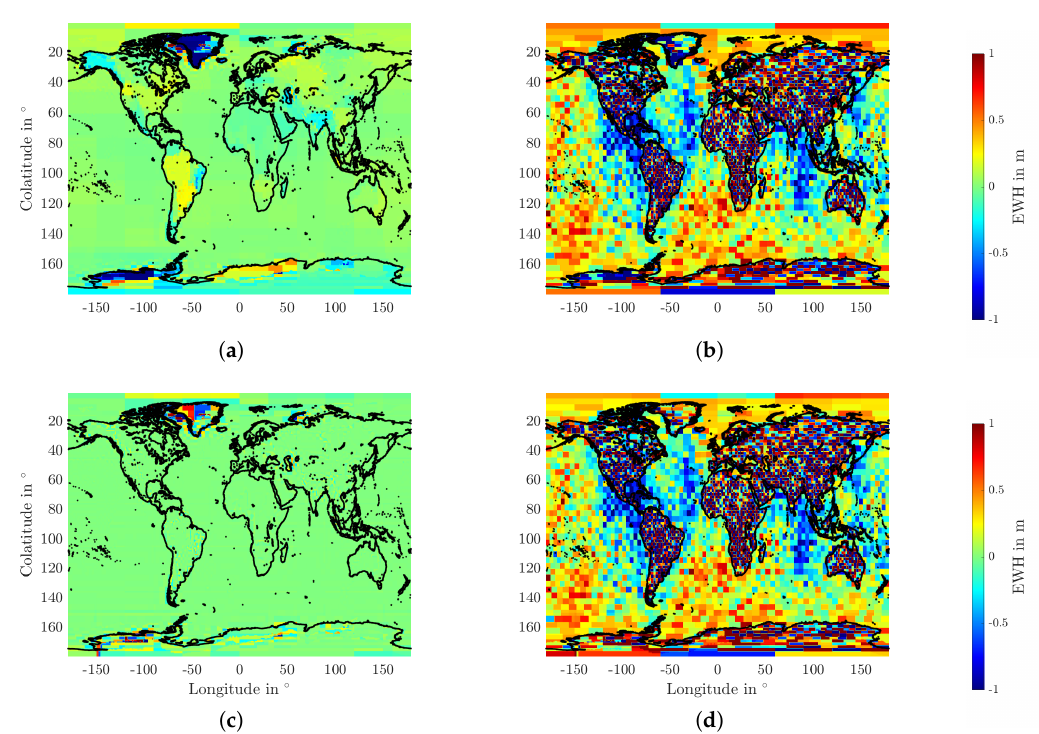
Figure 9. Mascon models resulting from ( a ) noise-free and ( b ) colored-noise synthetic SGG data generated as described in Section 2.1.2. The resolution of the computed models is 2 ◦ over the land and 4 ◦ over the ocean areas, corresponding to the spatial grid presented in Figure 6. Panels ( c , d ) show the differences of the models (a,b) to the original signal shown in Figure 4. For the plots involving the colored-noise model (b,d), the global mean value of the colored-noise mascon model of 25.167m EWH has been subtracted. This non-zero mean value can be explained by a missing regularization of the mascon NEQ system with respect to the very large-scale parts of the gravity field, particularly the sum of all mascons, which is very weakly determined by the data, as can be seen in the filter models shown by Figure